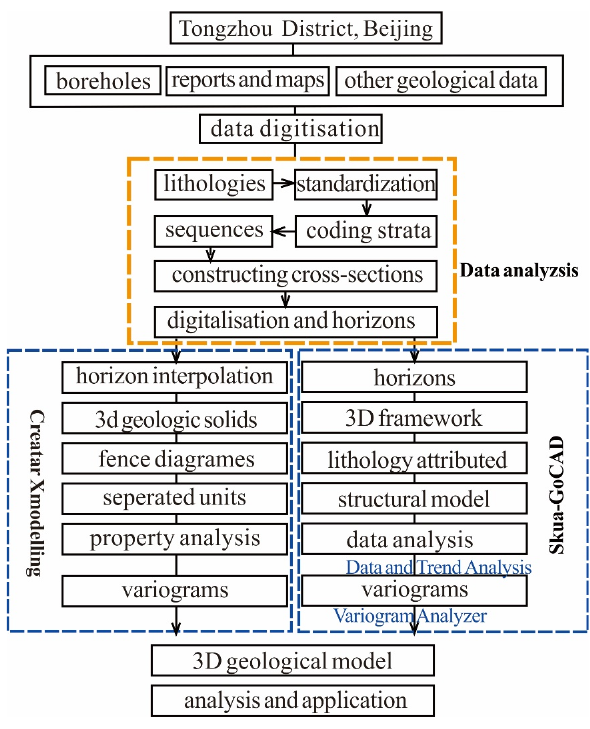
Figure 2. The modeling workflow.